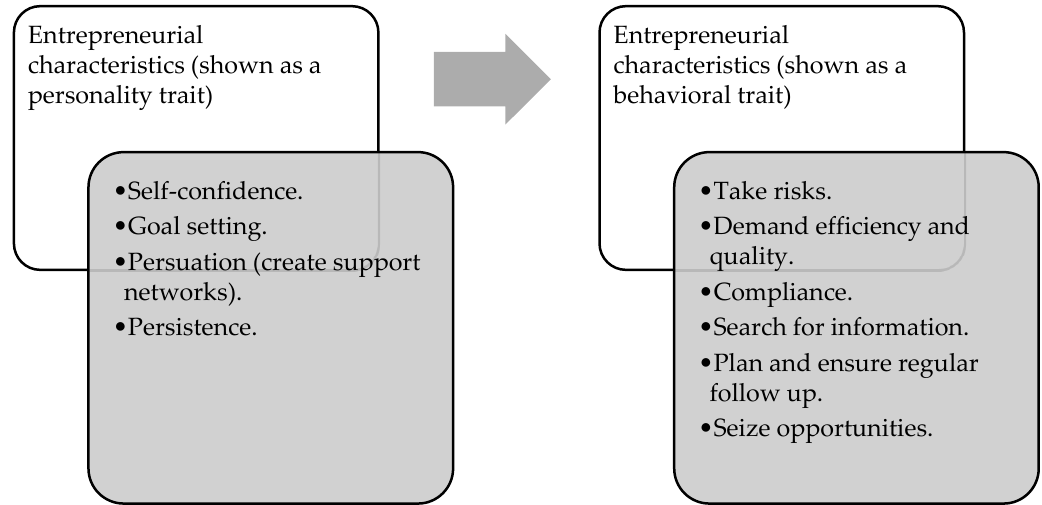
Figure 1. Entrepreneurial characteristics related to pull motivation. Source: authors.